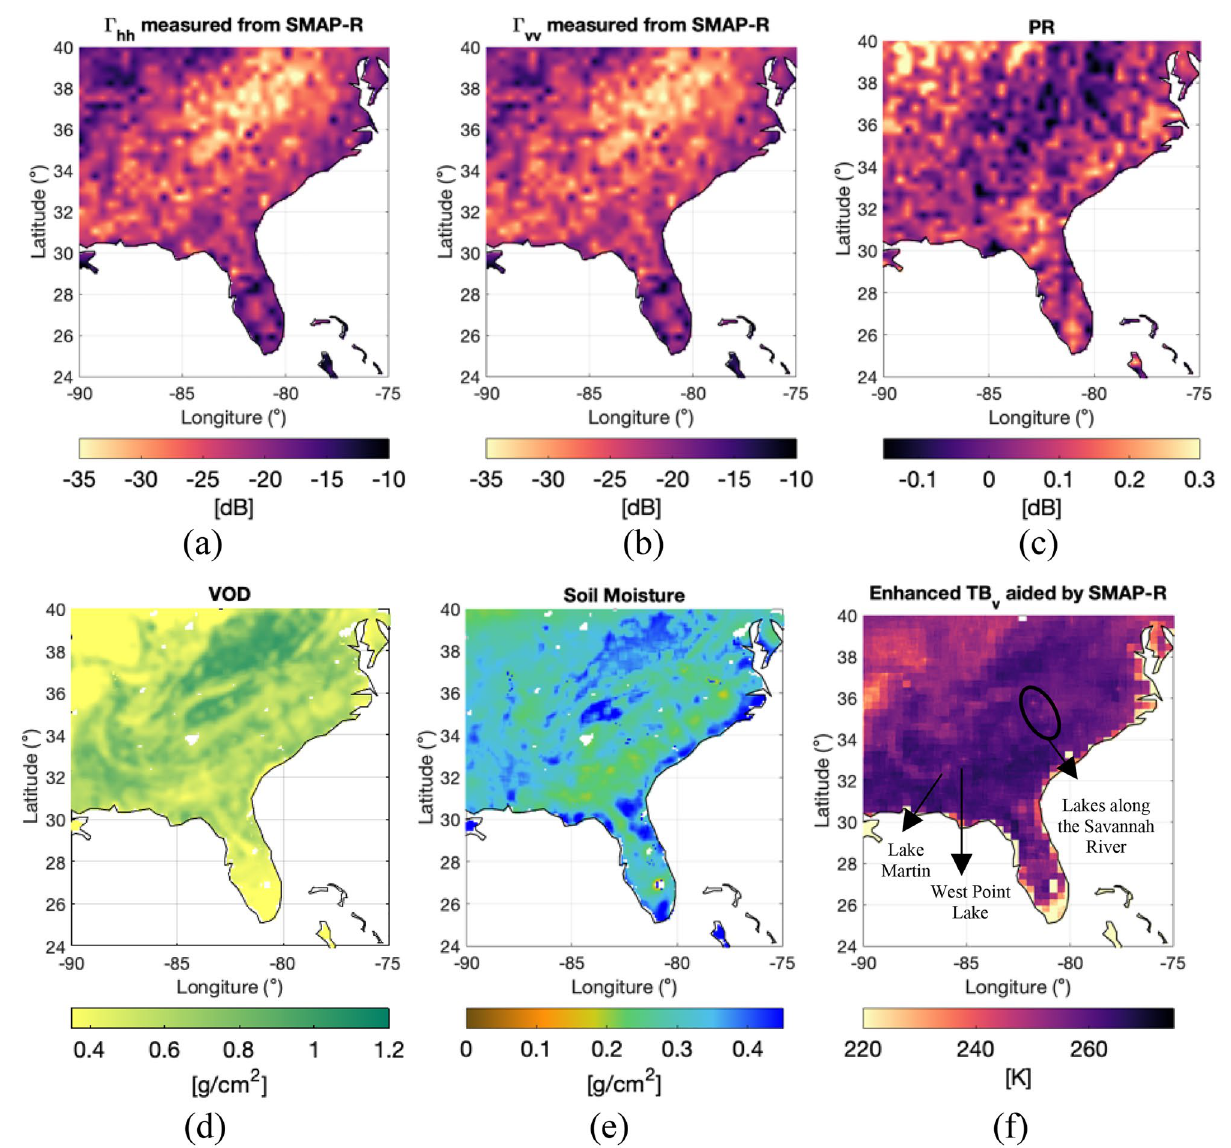
Figure 5. Aided-interpolation of SMAP radiometer data using SMAP-Reflectometer data over the study region: ( a ) SMAP-Reflectometer Ŵ hh at 9 km, ( b ) SMAP-Reflectometer Ŵ vv at 9 km, ( c ) Polarimetric ratio computed as PR = (Ŵ hh − Ŵ vv )/(Ŵ hh + Ŵ vv ) , ( d ) VOD of the region, ( e ) soil moisture of the region, and ( f ) resulting SMAP T Bv at 9 km. All figures made with Matlab R2021b (version 9.11.0.1809720, URL: https:// www. mathw orks. com/ produ cts/ new_ produ cts/ relea se202 1b.